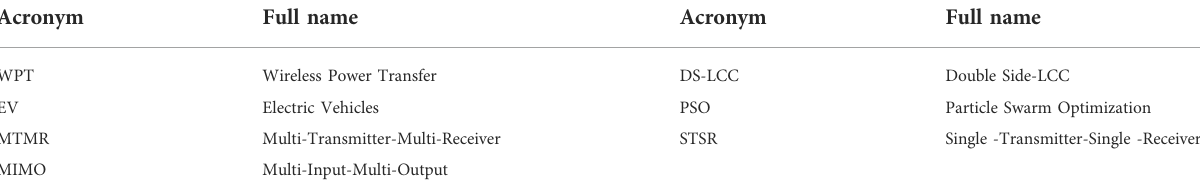
TABLE 4 The table of acronyms and their full